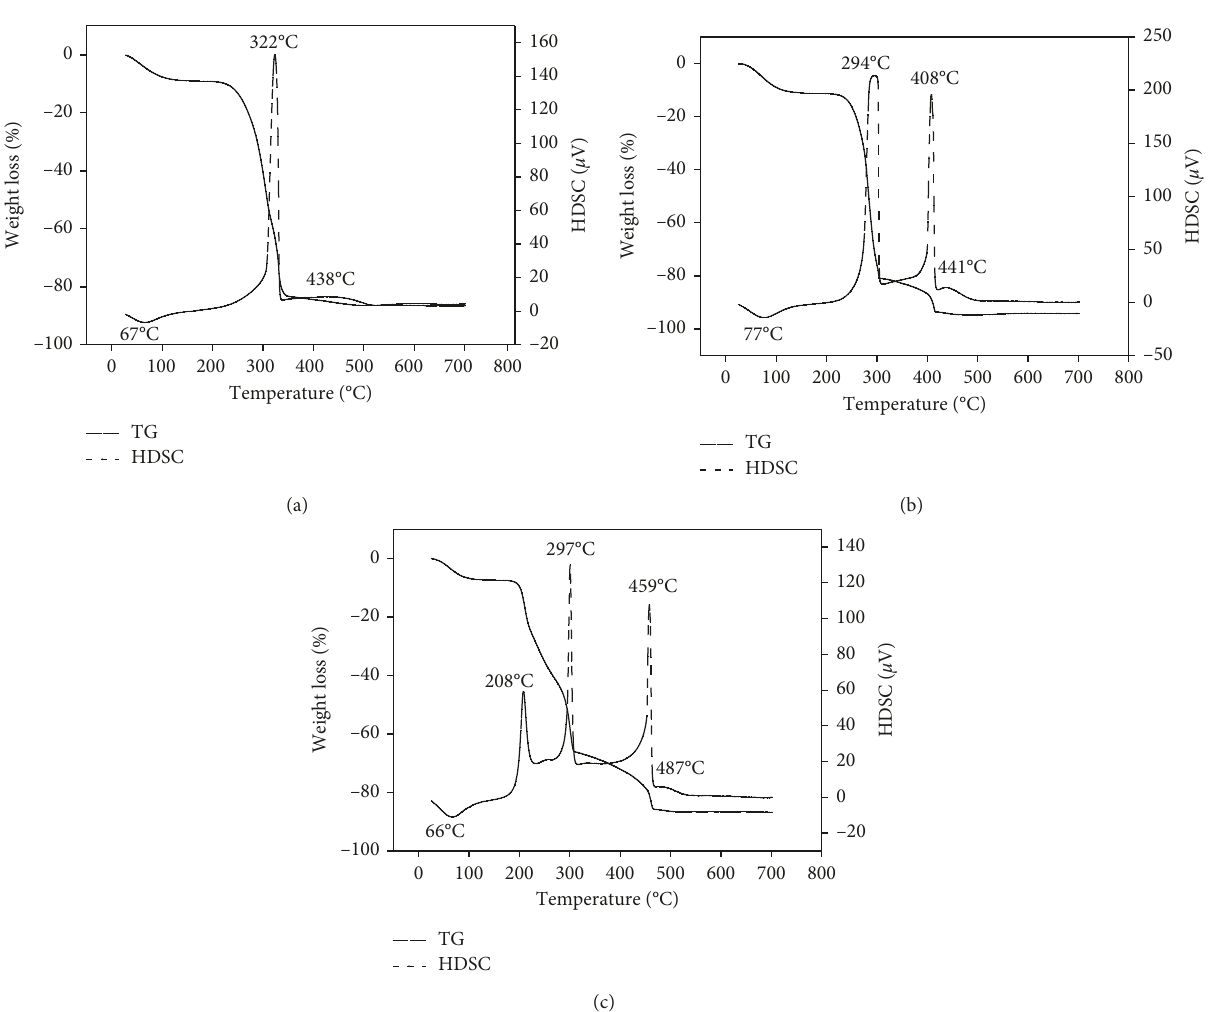
Figure 2: TG-HDSC curves of (a) raw POF, (b) NaOH-treated POF, and (c) CTAB-modified